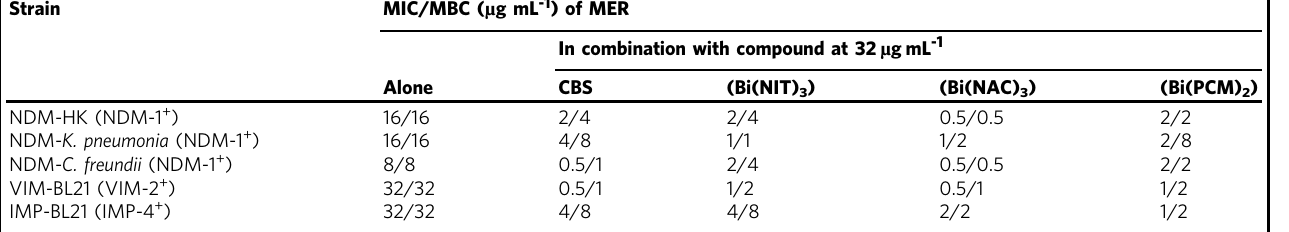
Table 1 Antibacterial activity of MER with Bi(III) compounds against different bacteria Strain MIC/MBC ( µ g mL -1 ) of MER In combination with compound at 32 µ g mL -1 Alone